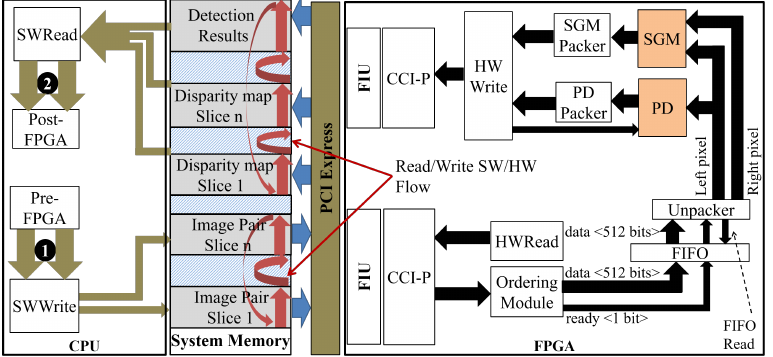
Figure 12. The PCP System heterogeneous architecture. The arrow labeled with the number 1 means the left and right rectified images. The arrow labeled with the number 2 means the disparity map and detection results. Pre-FPGA stands for the steps prior to FPGA processing (i.e., rectification). Post-FPGA stands for the steps after the FPGA processing (i.e., distance estimation, NMS, and so